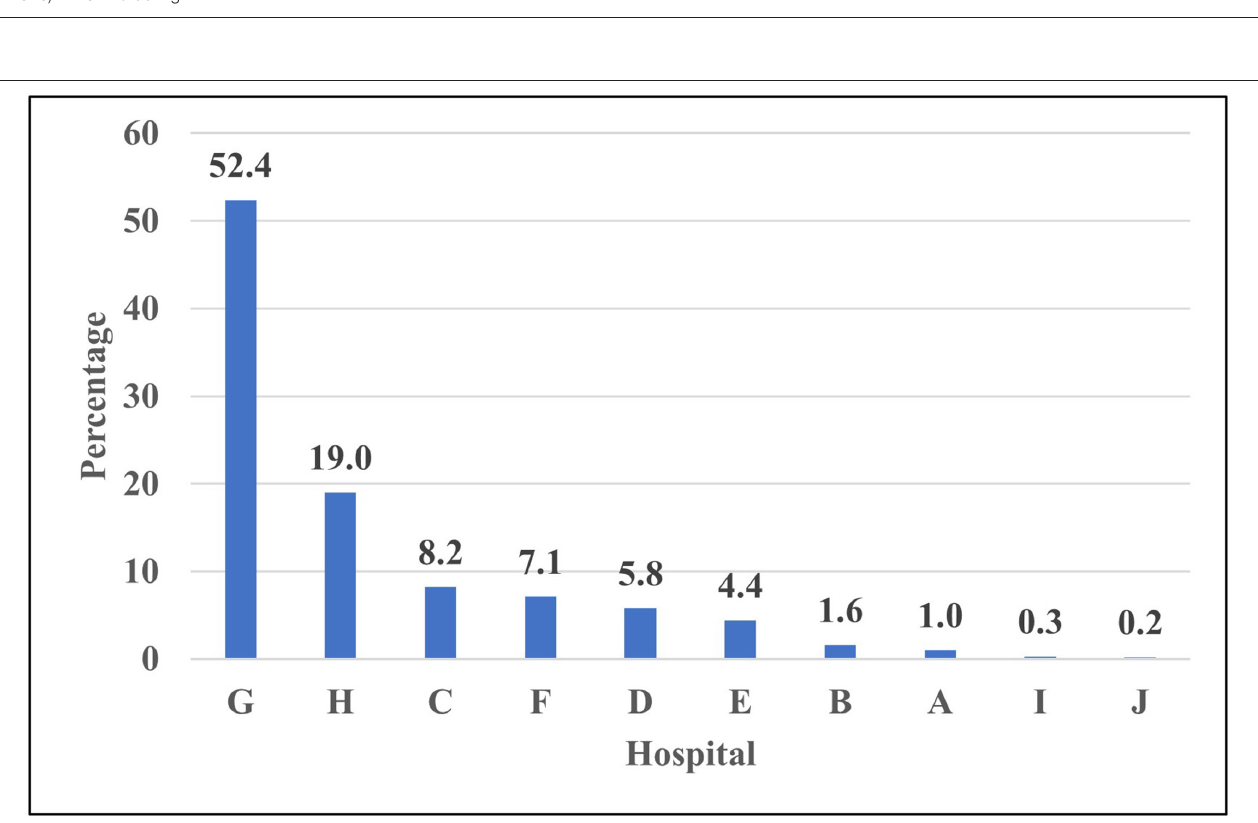
FIGURE 4 | Percent distribution of screened medical personnel with COVID-19 triage across 10 Teaching hospitals—Egypt: (June 1 to July 15, 2020) —Rank ordering.